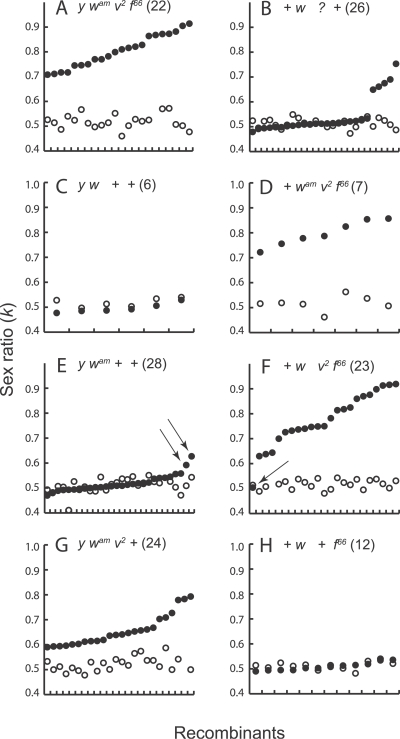
Sex Ratios (k) Scored for the Preliminary MappingEach recombinant X chromosome in classes A–H (Figure 1) was tested against nmy (filled circle) and its sex ratio was rank-ordered within each class. Also shown are the corresponding sex ratios tested against nmy/+ (open circles) as control and the number of recombinants tested for each class (in parenthesis). Three exceptional recombinants are indicated with arrows.